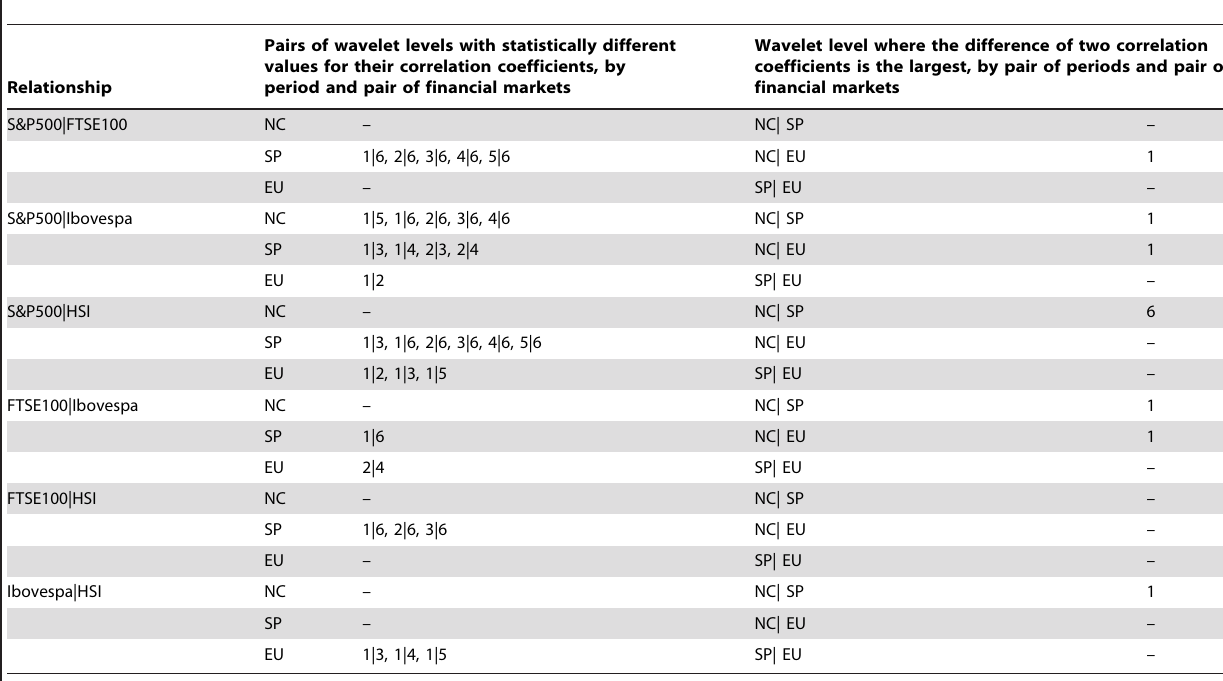
Middle panel: pairs of wavelet levels with statistically different values for their correlation coefficients, by period and pair of financial markets. Right panel: wavelet level where the difference of two correlation coefficients is the largest, by pair of periods and pair of financial markets. *Wavelet level n corresponding to 2 n-1 trading days.